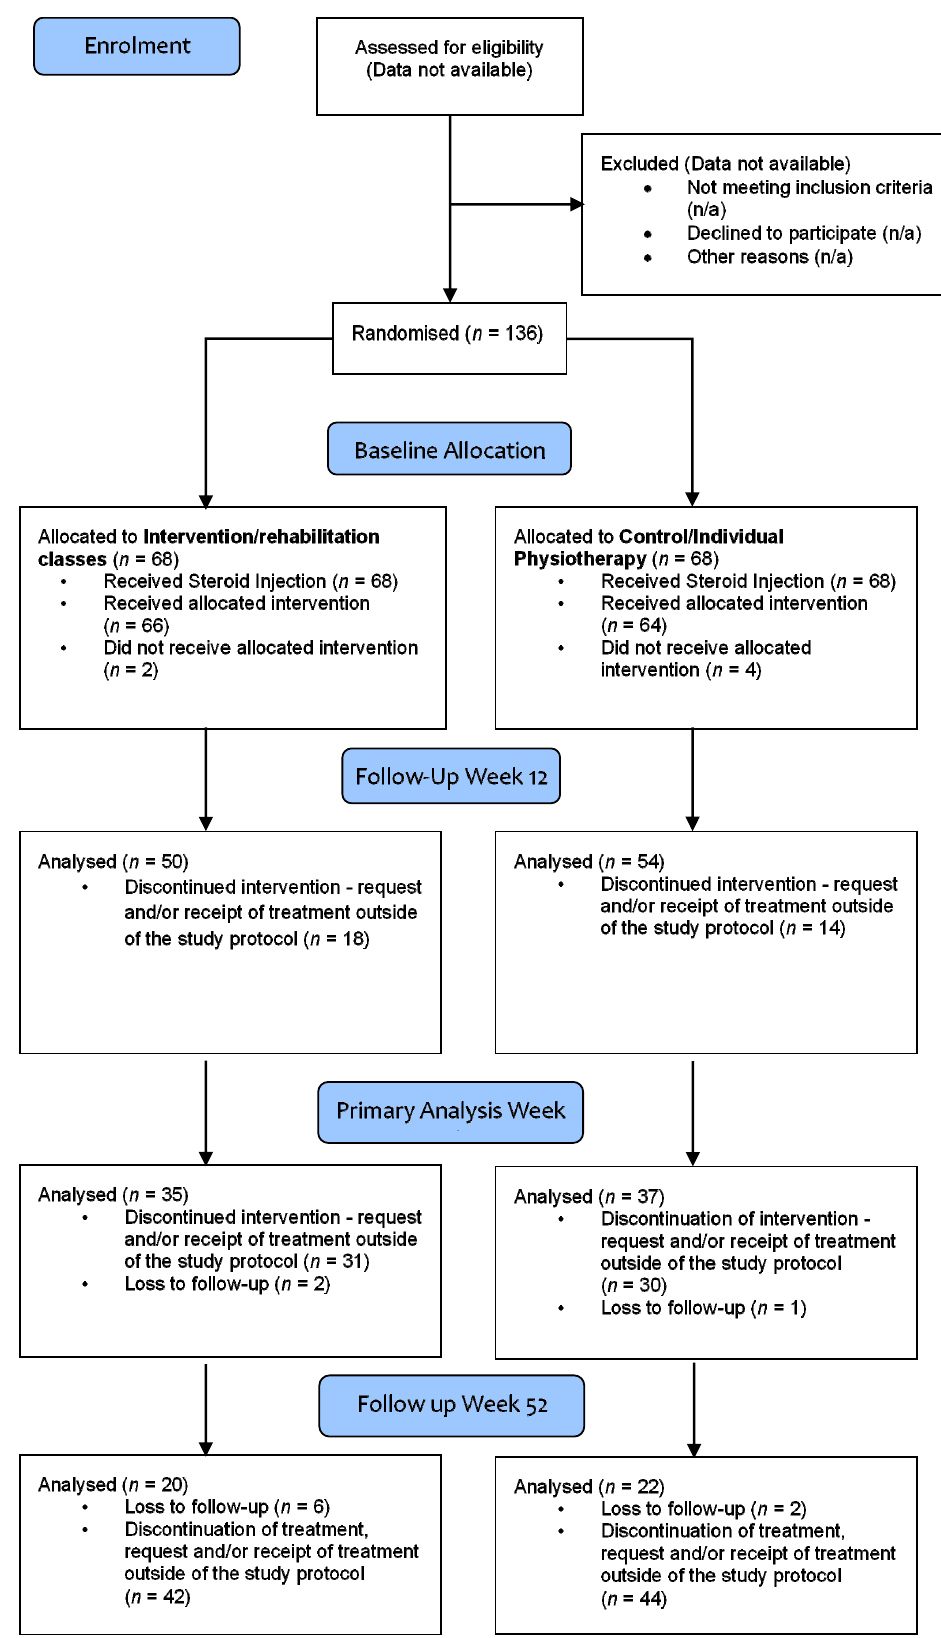
Figure 1. Consolidated Standards of Reporting Trials (CONSORT) diagram.